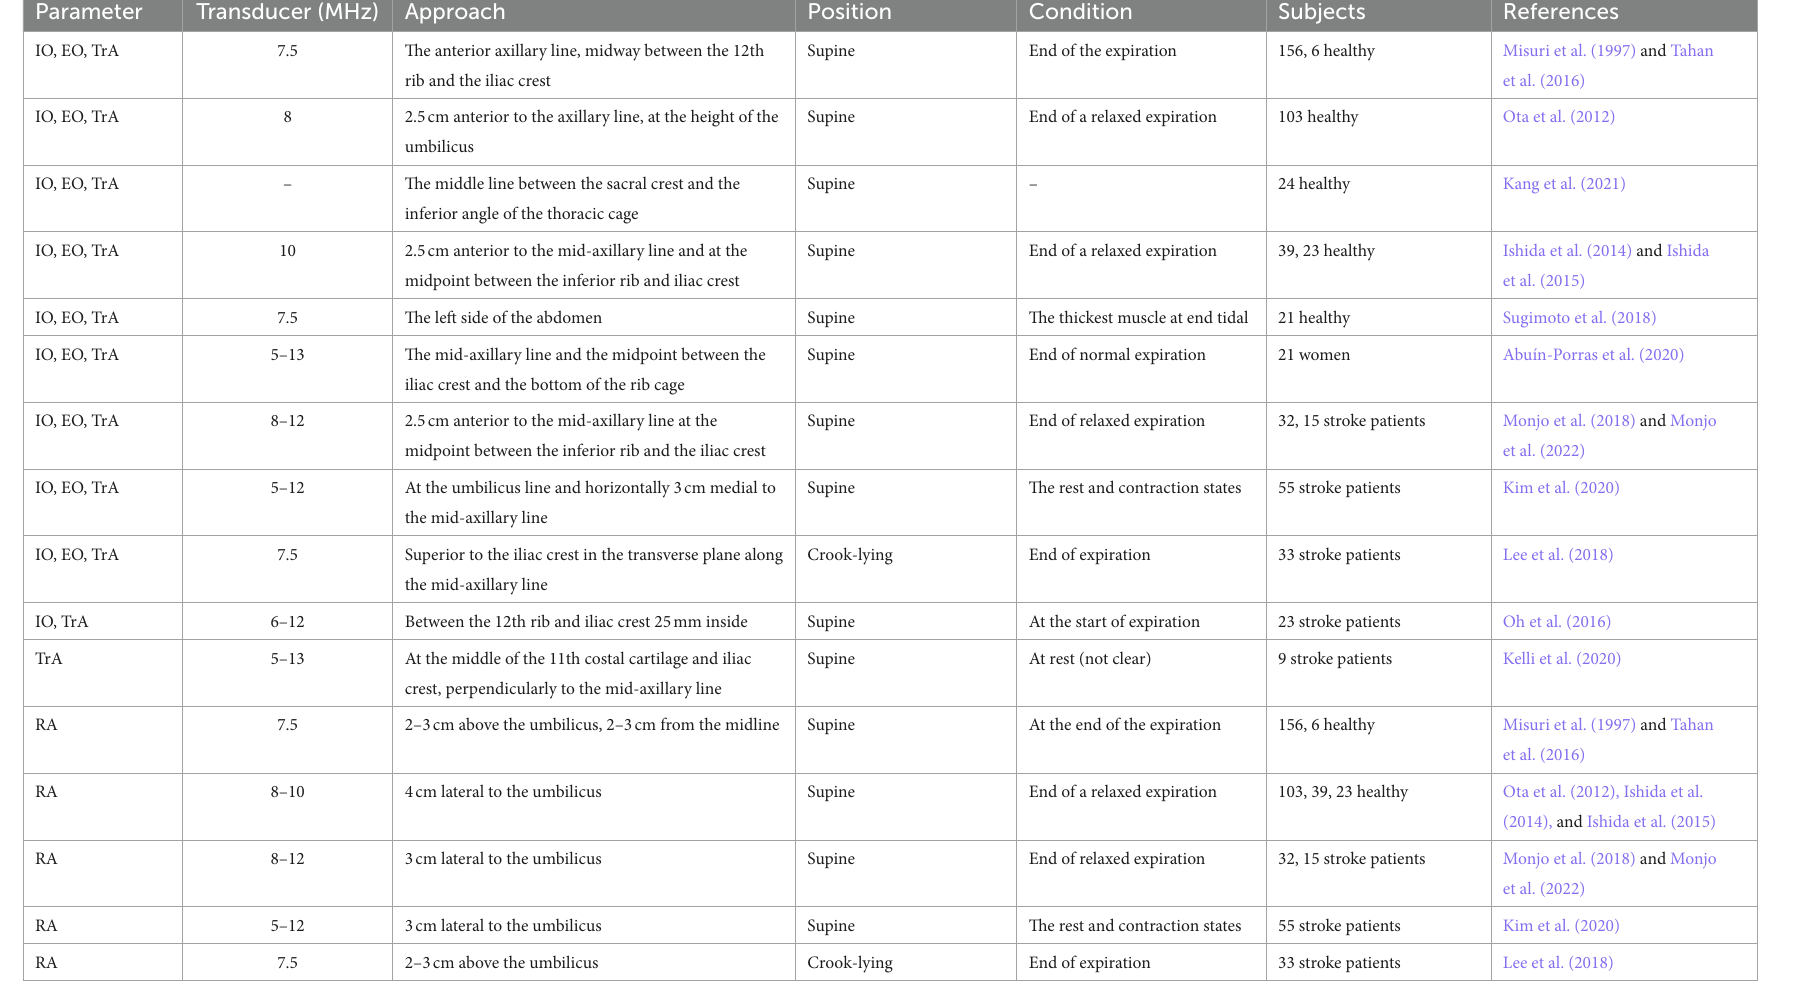
TABLE 3 Selected studies providing direct visualization of ultrasonographic assessment of the expiratory muscles’ thickness.